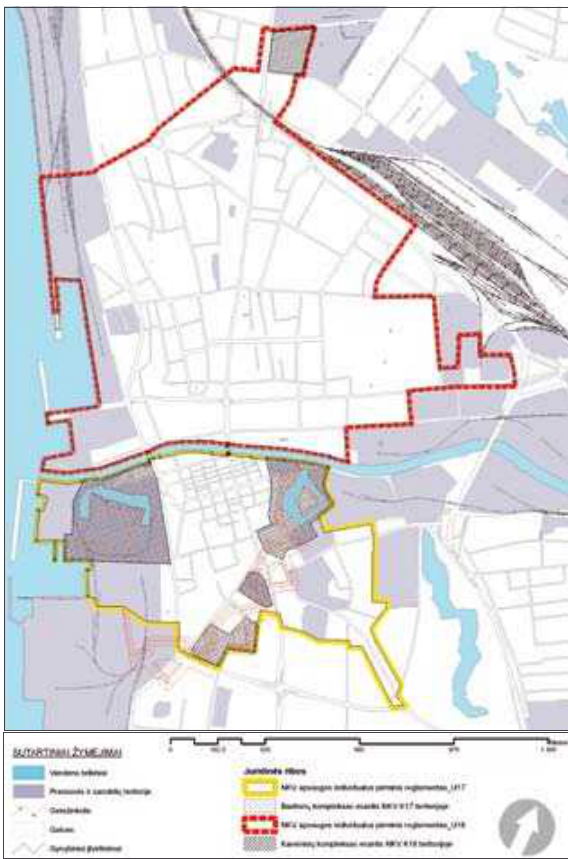
Fig. 4. r­esumptive scheme for historical development of the city